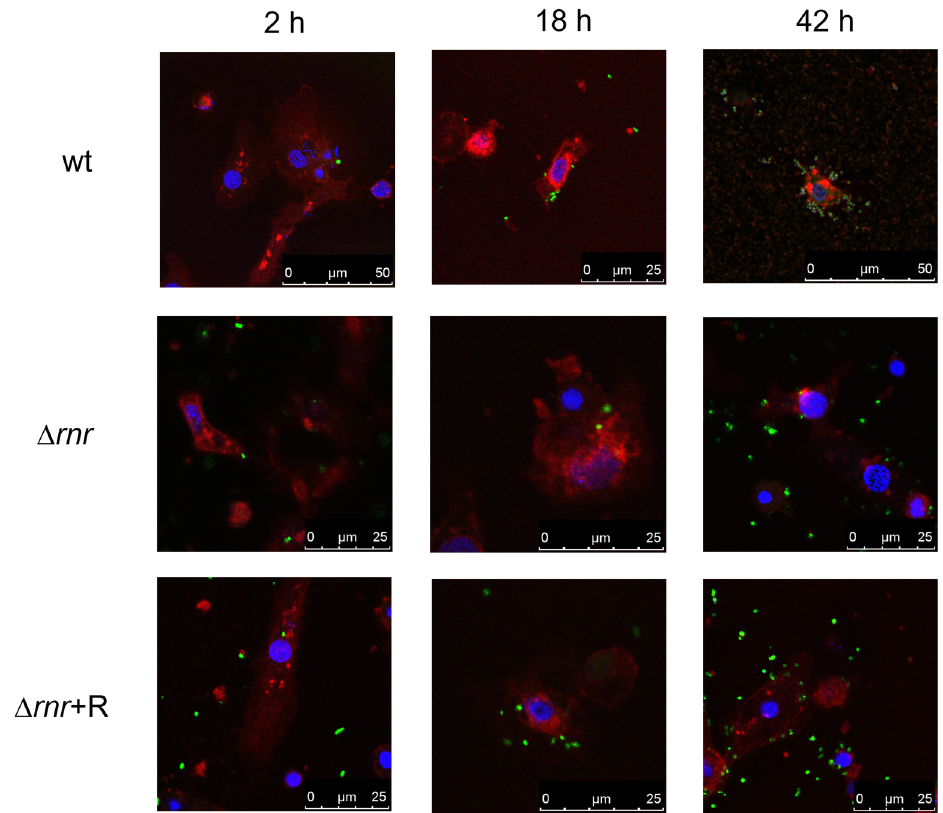
Figure 4. G. mellonella hemocytes as ex vivo infection model for S. pneumoniae strains. Fluorescence confocal microscopy images of the primary hemocytes cell cultures infected with the S. pneumoniae TIGR4 wild type (wt), RNase R mutant ( ∆ rnr ), and ∆ rnr expressing RNase R in trans ( ∆ rnr +R) strains at 2, 18, and 42 h postinfection. Hemocyte membranes were labeled with WGA conjugated with Alexa 633 (red), while bacteria were stained with S. pneumoniae monoclonal antibody and Alexa 488 (green), and Hoechst dye was used for staining the cell’s nucleus (blue). Experiments were repeated at least three times, and one representative experiment of the overlay between the three dyes is shown.